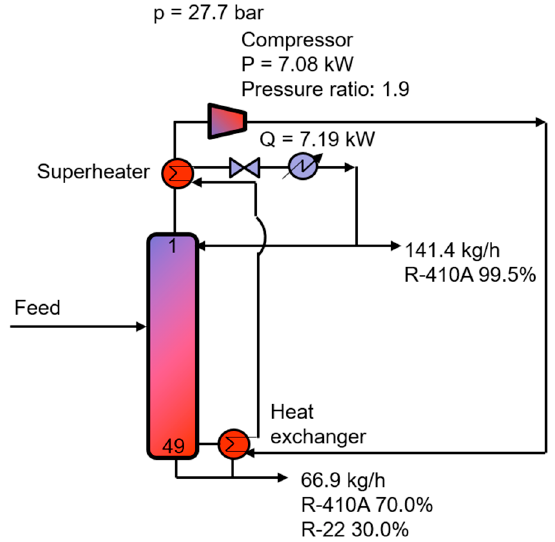
Figure 4. Simplified flowchart illustrating the MVR heat-pump-assisted conventional column with top vapor